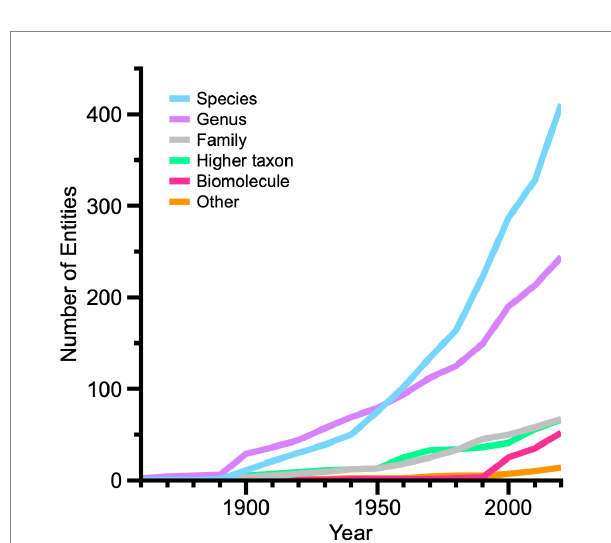
FIGURE 5 Line graph showing relative changes among 853 unique living fossil entities (taxonomic and non-taxonomic) at different levels in the biological hierarchy from 1860 to 2020. Entity names are summed by decade, based upon earliest occurrences in our